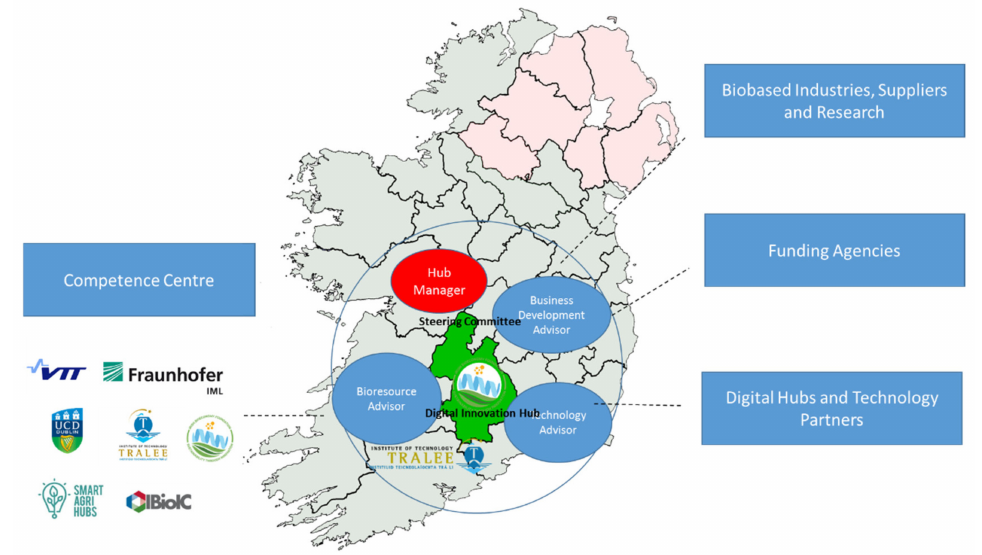
Figure 7. Irish DIH structure and how it integrates with the already existing bioeconomy